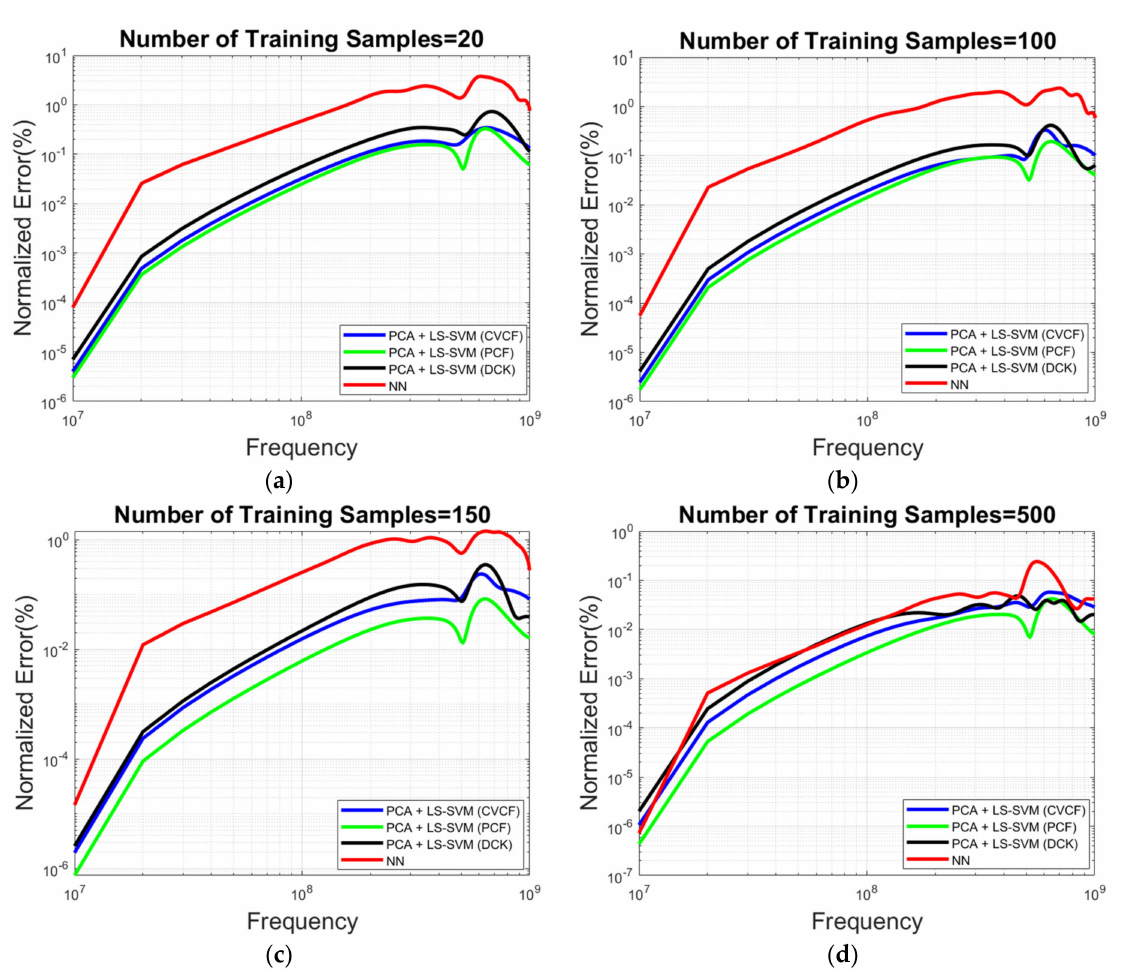
Figure 6. Comparison of the relative NRMSE values computed by the proposed approaches and a feedforward multi-output neural network on the test samples by considering the real part of the transfer function of a high-speed link for an increasing number of training samples ( a ) L = 20; ( b ) L = 100; ( c ) L = 150; ( d ) L = 500).